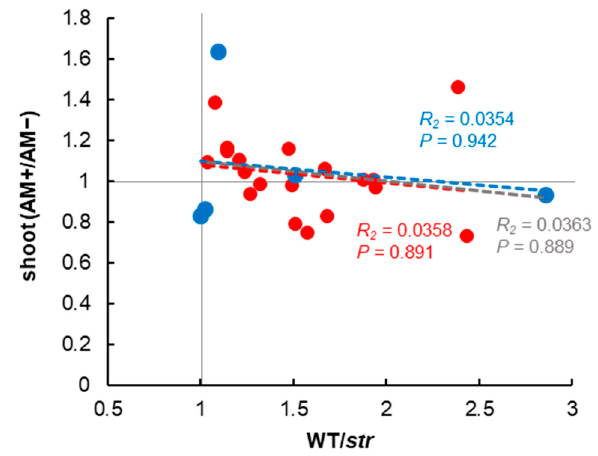
Figure 3. The relationship between the performance of indigenous arbuscular mycorrhizal fungi and the effects of the inoculation of exotic arbuscular mycorrhizal fungi in the soils. To evaluate the performance of indigenous AMF in the soils, we examined the growth ratios of wild-type and str mycorrhizal mutant using 24 soils. The effect of the inoculation of exotic AMF (Rhizophagus irregularis R-10) is shown by shoot weight ratio (inoculated/uninoculated). Red- and blue-dotted line is the regression line calculated from the values of non-cultivated soils and cultivated soils, respectively. Gray-dotted line is the regression line calculated from all data.